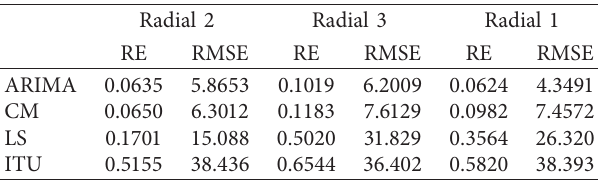
Figure 6: Graphs of combined ARIMA model adjust for radial 2 (a) and estimates for radial 3 (b) and 1 (c). Table 2: RE and RMSE values for interpolated